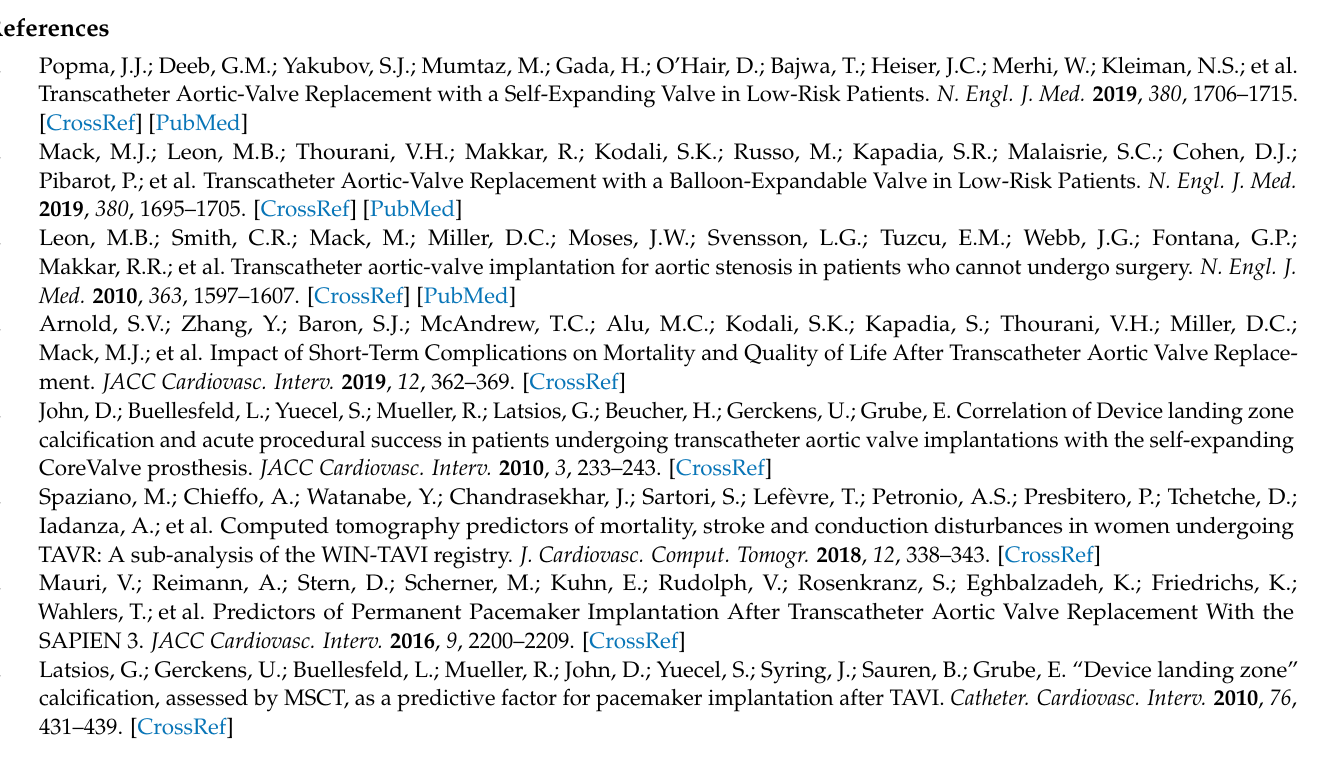
Figure A1. This figure shows the unadjusted (before matching) and adjusted (after matching) stan- dardized mean differences of the matched parameters. Absolute standardized mean differences < 0.1 were considered indicator of adequate balance.